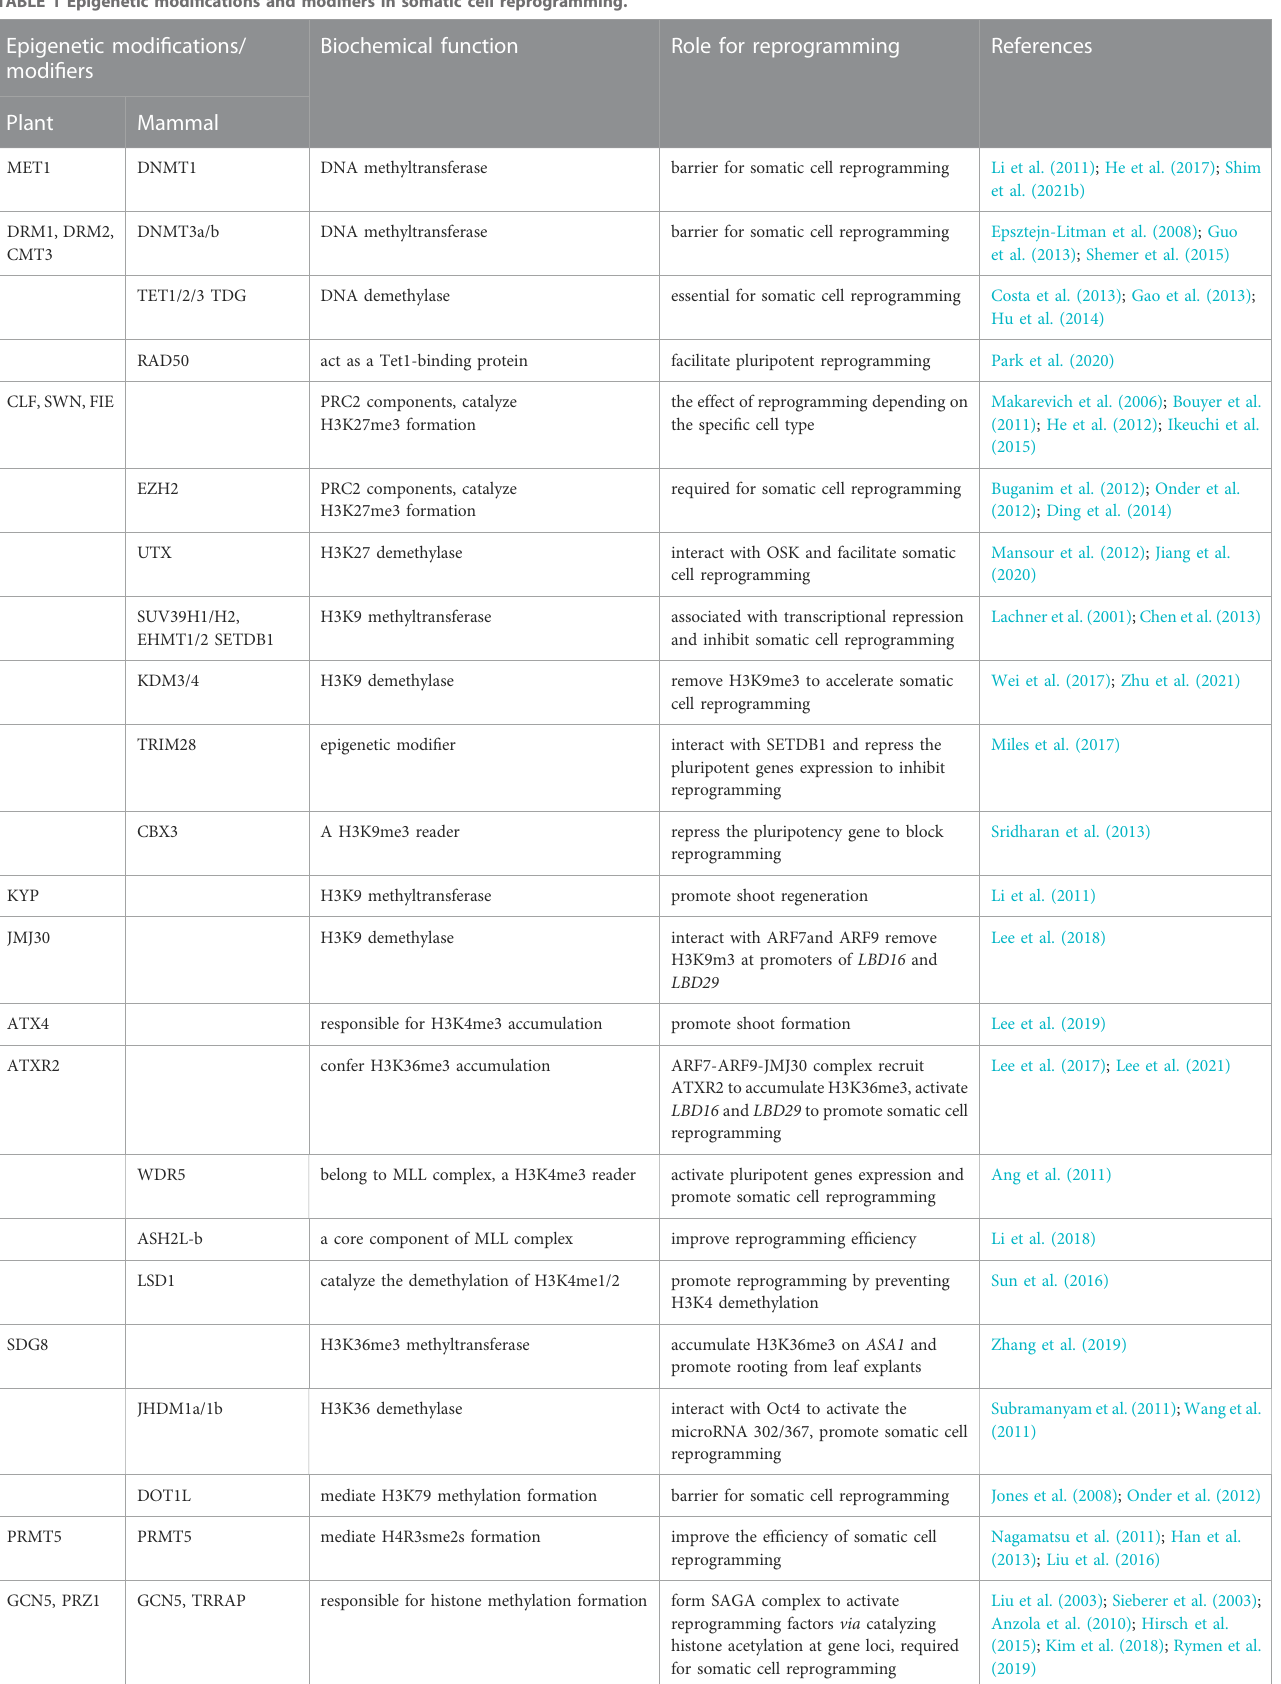
TABLE 1 Epigenetic modi fi cations and modi fi ers in somatic cell